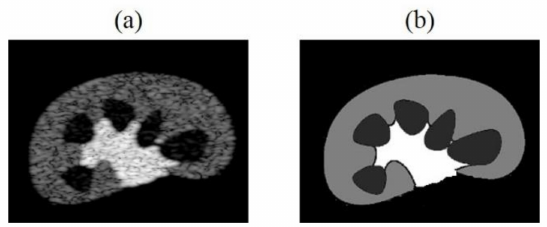
Figure 13. ( a ) Kidney simulation B-mode image and ( b ) echogenicity